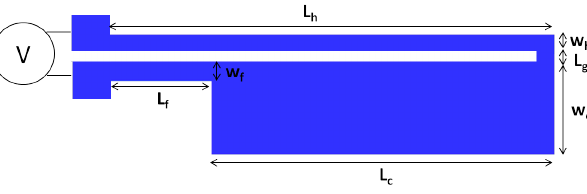
Figure 5. Top view of the electrothermal actuator with labelled